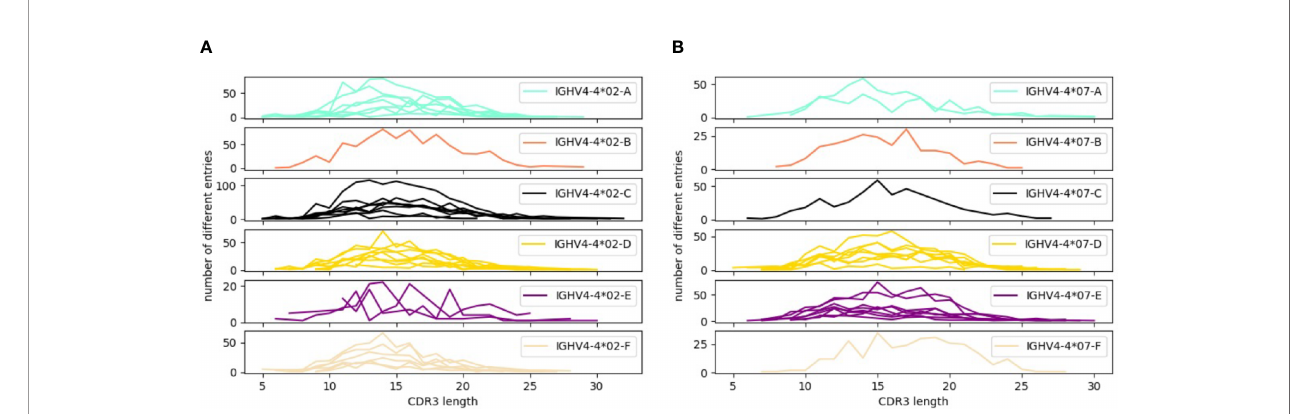
FIGURE 3 | Distribution patterns of CDR3 length encoded by transcripts associated to 5 ’ UTR-leader sequences of (A) IGHV4-4*02, (B) IGHV4-4*07. For each 5 ’ UTR-leader sequence of a speci fi c allele, the number of fi ltered reads in each length of CDR3 was counted to create the plots. Every line in the plots represents the 5 ’ UTR-leader sequence from one subject (at maximum 8 subjects were included in each plot). Distribution patterns of CDR3 length for 5 ’ UTR-leader sequences of other alleles are displayed in Supplementary Figure 1